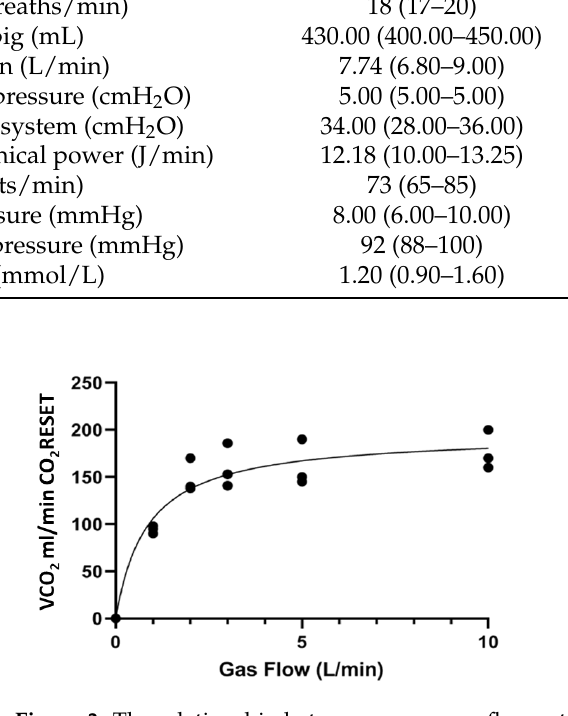
Figure 3. The relationship between sweep gas flow rate and the median CO 2 elimination (VCO 2 ) measured by the CO 2 RESET device with a fixed blood flow rate of 600 mL/min.